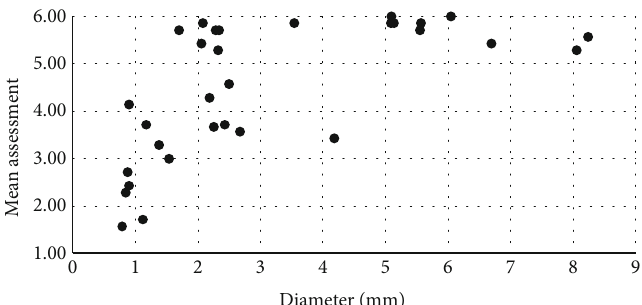
Figure 5: Average assessment from 7 readers vs. tumor size. Tumors larger than 3 mm received high ratings, indicating strong con fi dence of tumor presence. Table 2: Reader study sensitivity and speci fi city values. Diameter